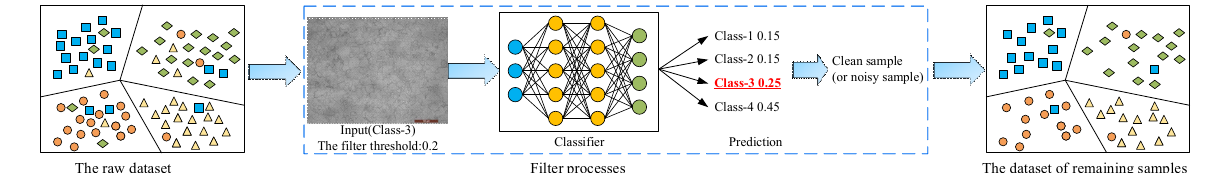
Figure 4. Process to filter out noisy samples.